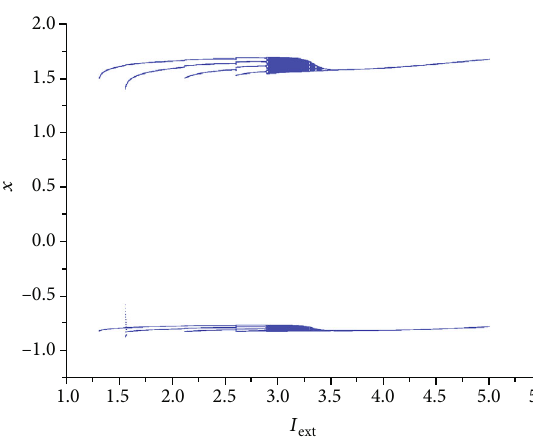
Figure 6: Bifurcation of membrane potential x (Poincare section at y = − 2 : 5 ) in model (2) with k = 0 : 1 and bifurcation parameter I